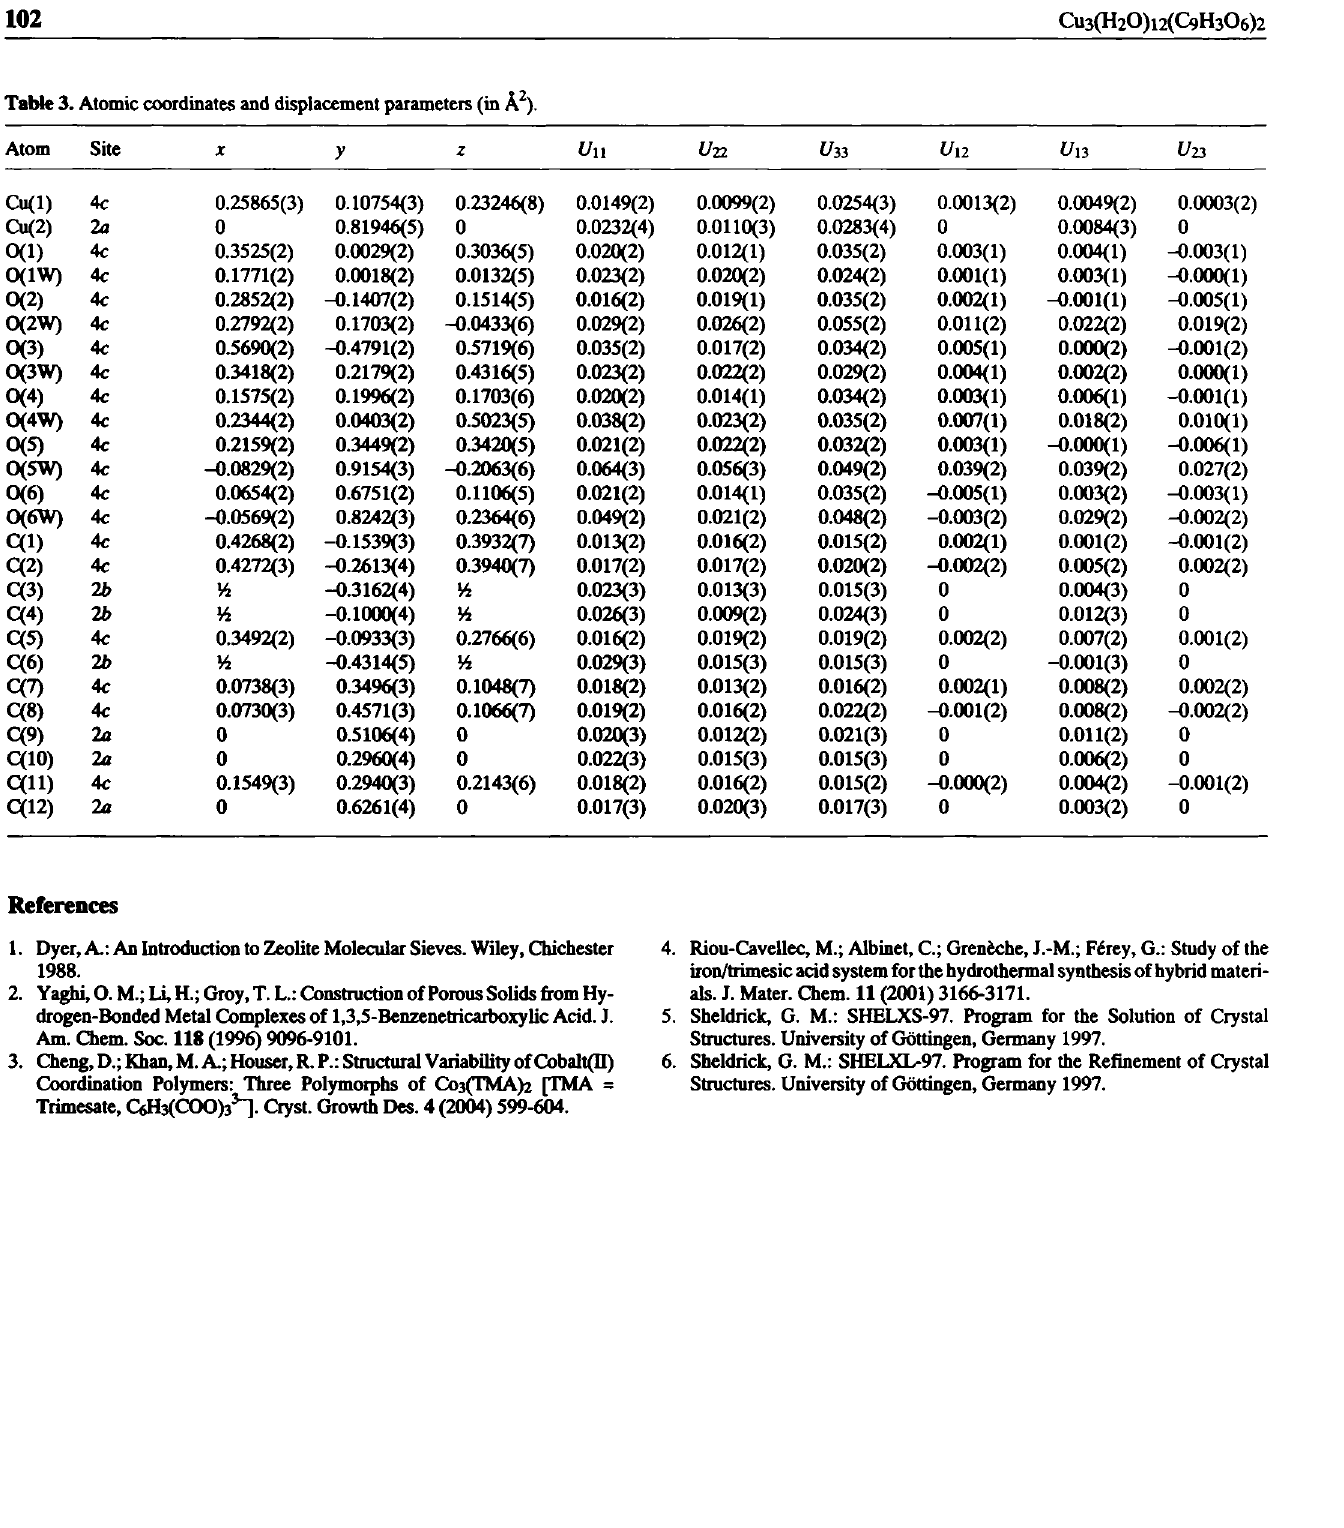
Table 3. Atomic coordinates and displacement parameters (in A 2